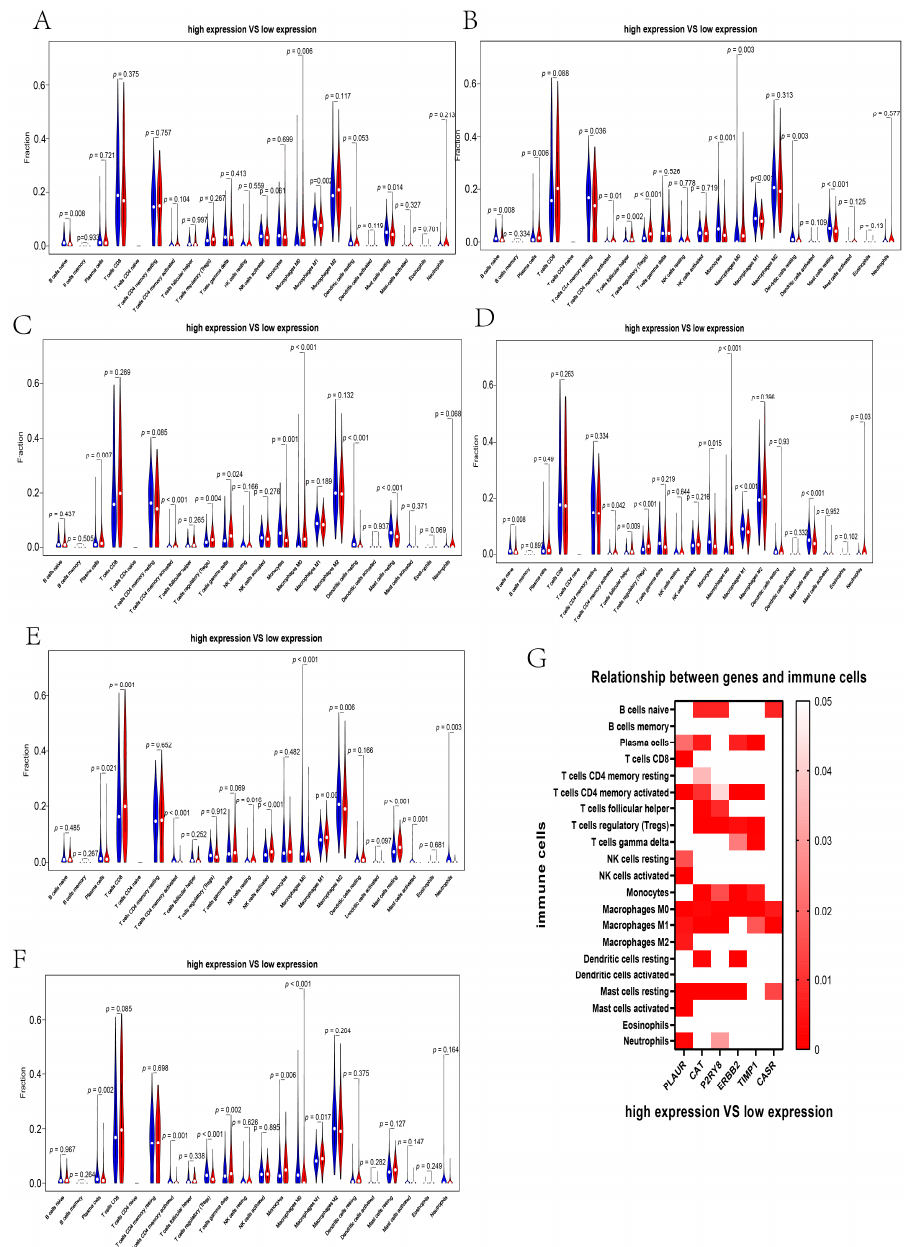
Figure 10. The correlation between immune infiltration and the expression of six hub genes. ( A – F ) Immune infiltration analysis of 22 immune cells with high and low expression of CASR the difference between high and low expression of hub genes and immune infiltrations of 22 immune cells. Red indicates that immune infiltration was significantly different. The more significant the difference, the darker the